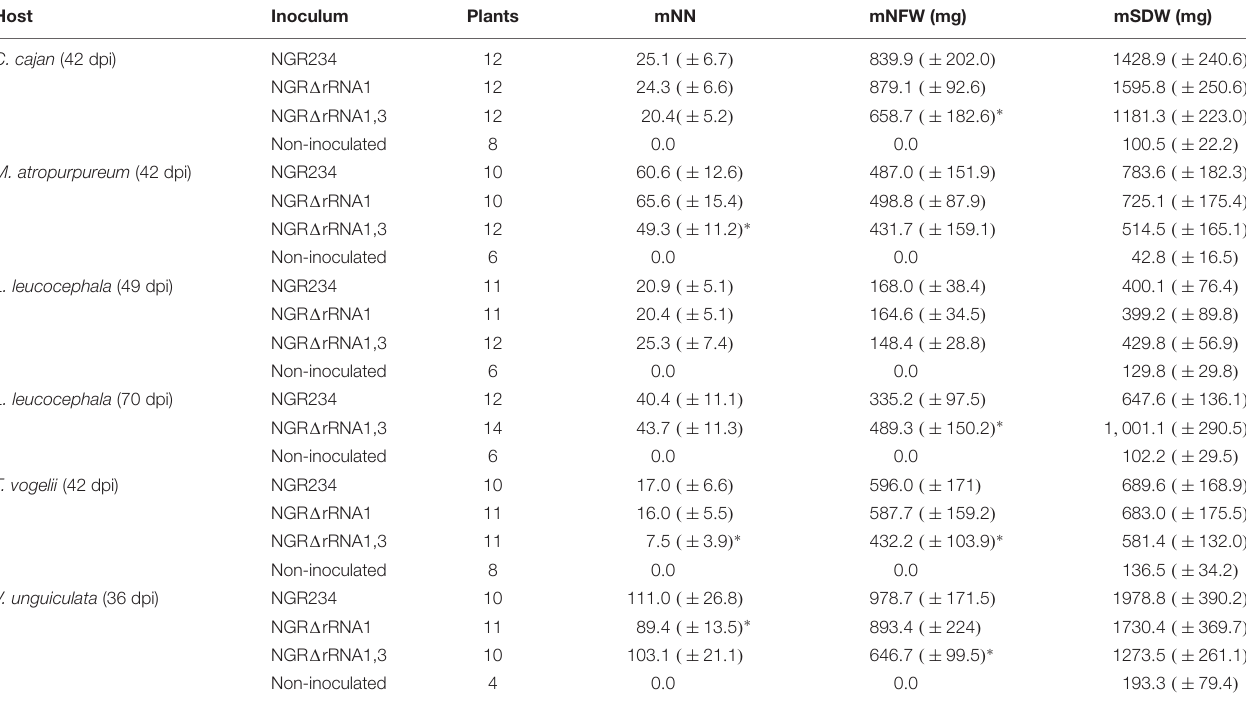
TABLE 1 | Symbiotic proficiency of NGR234, NGR (cid:49) rRNA1, and NGR (cid:49) rRNA1,3 on five legume species.